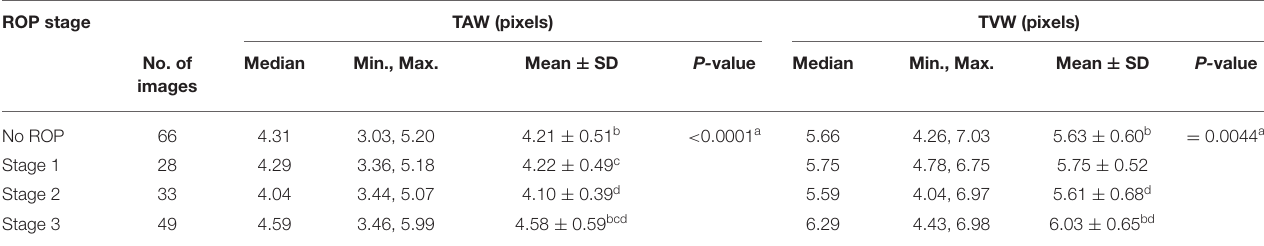
TABLE 3 | TAW and TVW in various stages of ROP. ROP stage